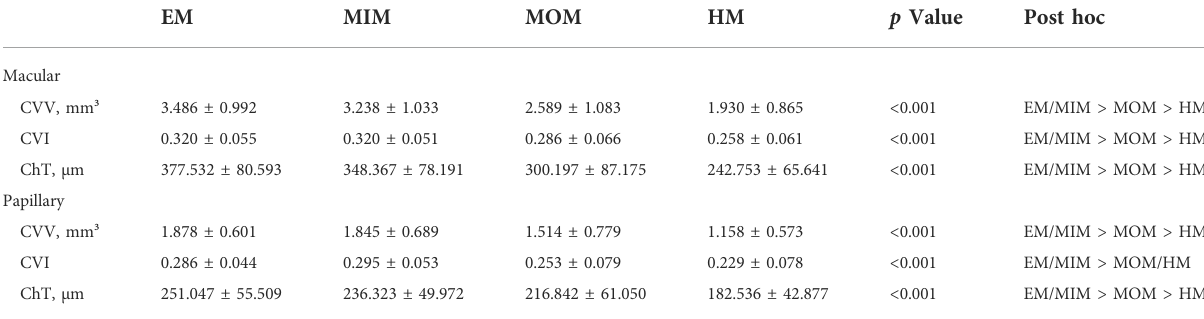
TABLE 2 Comparison of global CVV, CVI, and ChT in macular regions and papillary regions of different myopia groups.